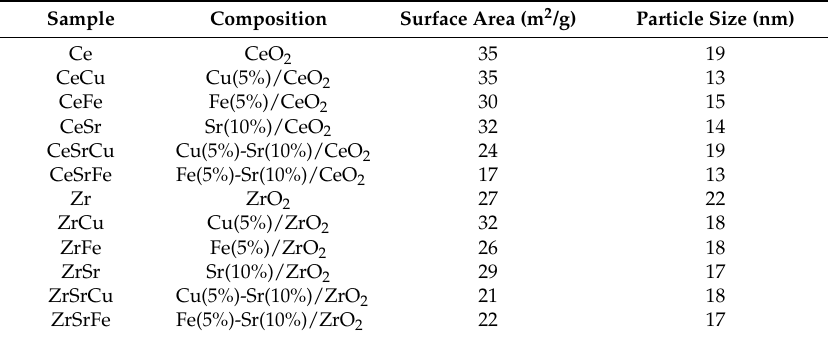
Table 1. Composition and textural characterization of investigated